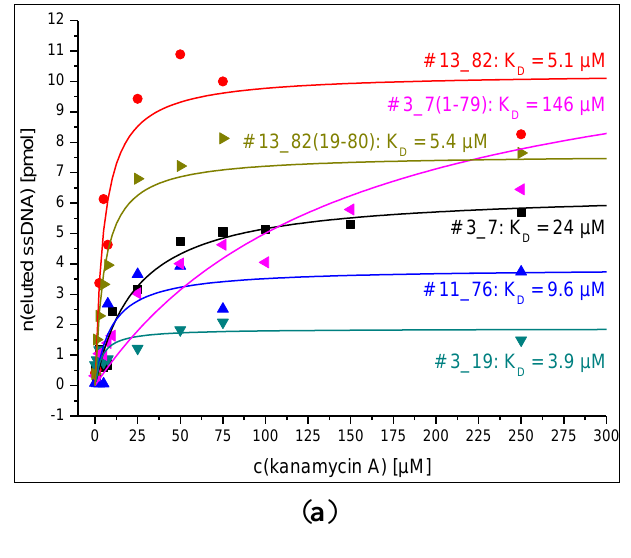
Figure 5. ( a ) Determination of dissociation constants by fluorescence detection using the bead assay; ( b ) by fluorescence detection using the MTP assay also showing two negative controls (aptamer truncations # 13_82(19-80) tested with paromomycin that is not bound and # 3_19(1-79), which lost binding properties due to truncation, together with kanamycin A; and ( c ) by SPR detection using Biacore X 100 (GE